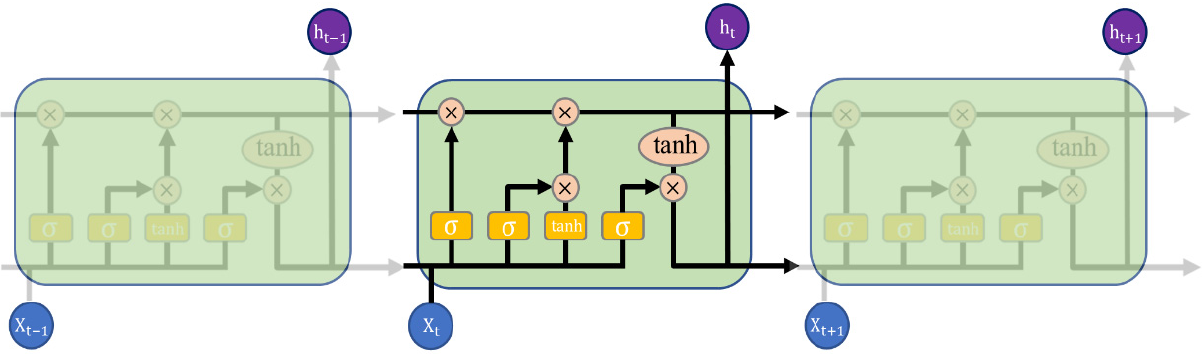
Figure 4. LSTM structure.